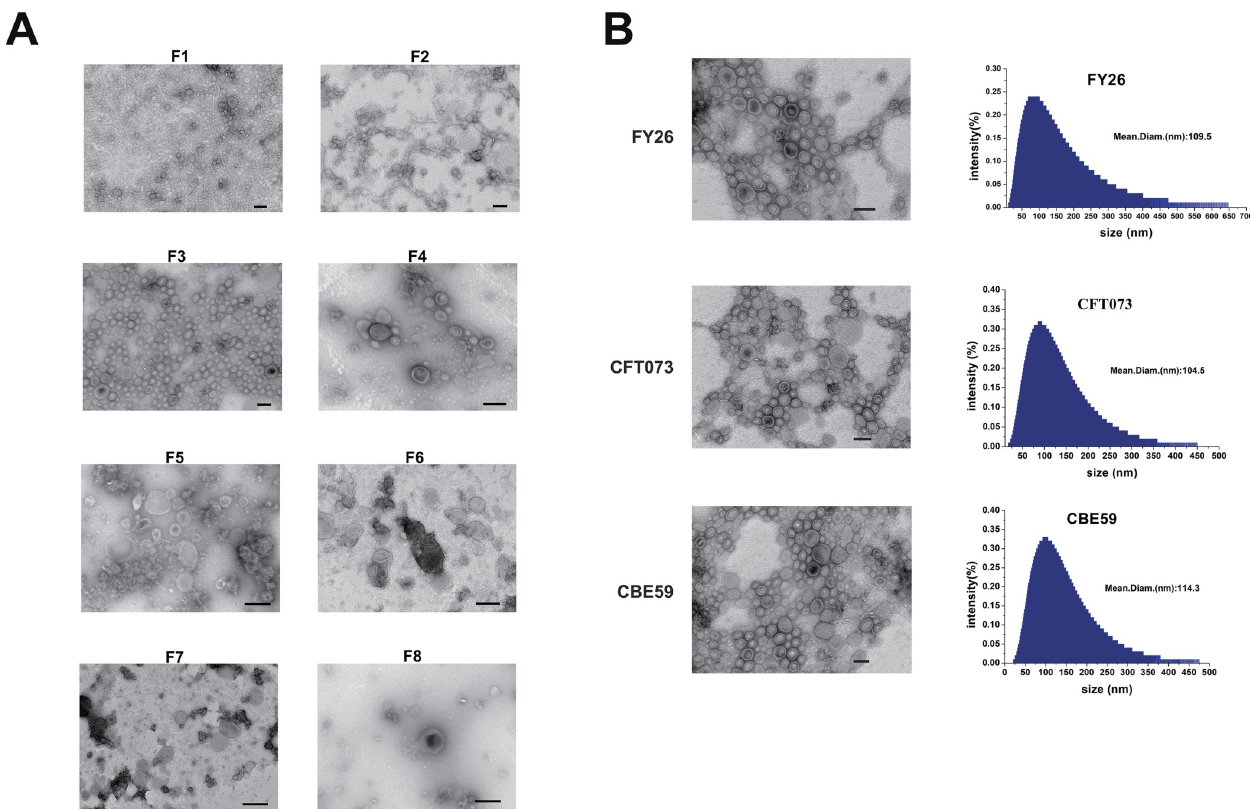
Fig 1. TEM visualization of the EVs produced by ExPEC strain. (A) The purified FY26 EVs obtained from fractions F1–F8 were visualized with TEM. Scale bars: 200 nm. (B) DGU-purified EVs of different ExPEC strains (FY26, CBE59, and CFT073) were observed with TEM. The size distributions of the three purified EVs were detected with Dynamic light scattering (DLS). Scale bars: 200